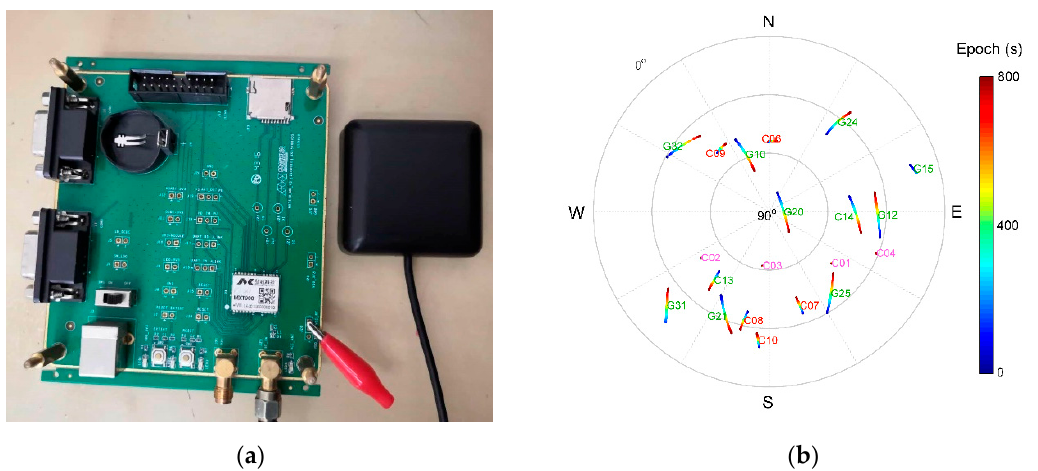
Figure 17. ( a ) Receiver and antenna used for dynamical experiment; ( b ) sky plots of satellites, satellite number in different colors represent type of orbits, for GEO in magenta, IGSO in red, and MEO in green.